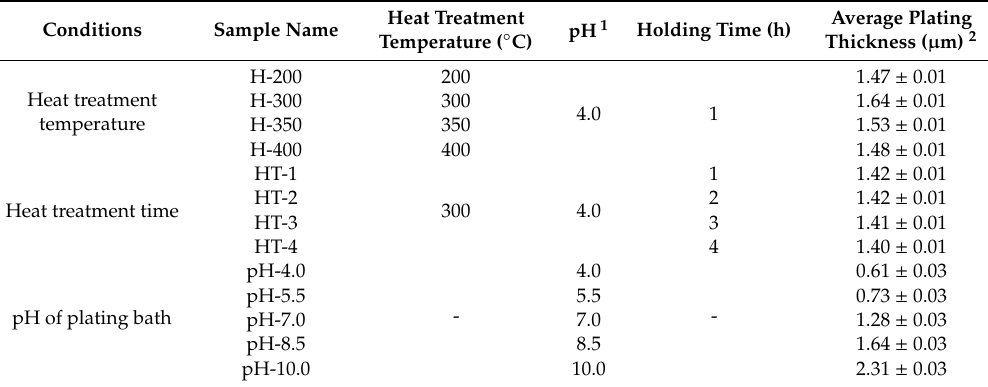
Table 1. Process conditions for electroless Ni-P plating of